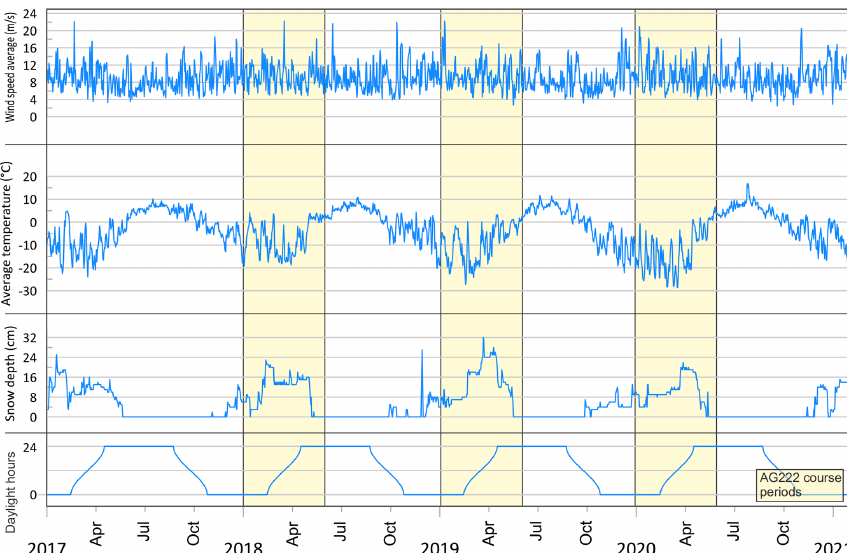
Figure 4. Extreme seasonal cycle, as exemplified by the amount of daylight hours, temperature, wind speed and snow depth in Adventdalen near Longyearbyen from 2017 to 2021 (meteorological source: https://klimaservicesenter.no/, last access: 7 September 2021). The AG222 course and field periods are marked – these are characterized with maximum snow cover and lowest temperatures and a rapid shift from no daylight to permanent daylight during the course